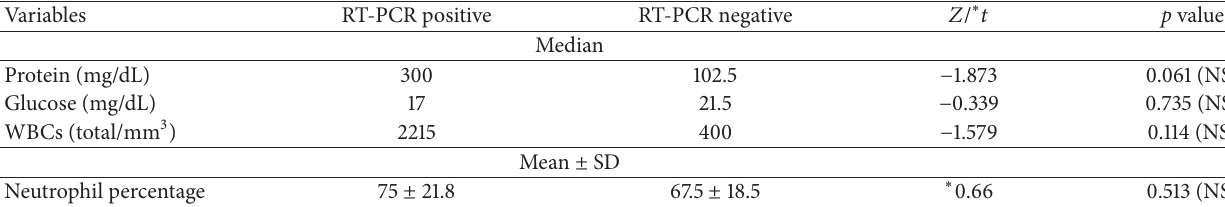
Table 4: Comparison between real-time PCR positive and negative samples as regards CSF cells and chemistry results.